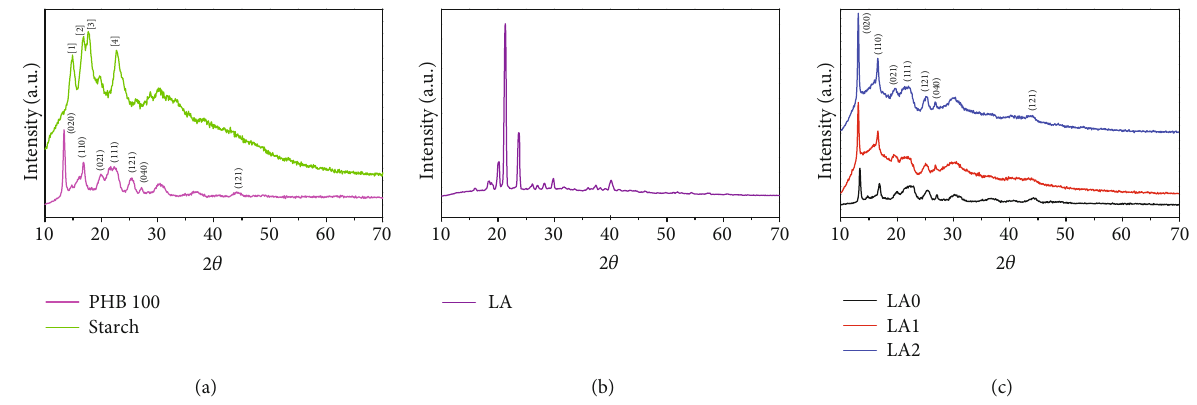
Figure 3: XRD results. (a) PHB 100 and starch powder. (b) LA powder. (c) LA0, LA1, and LA2. Table 3: EDS values of selected